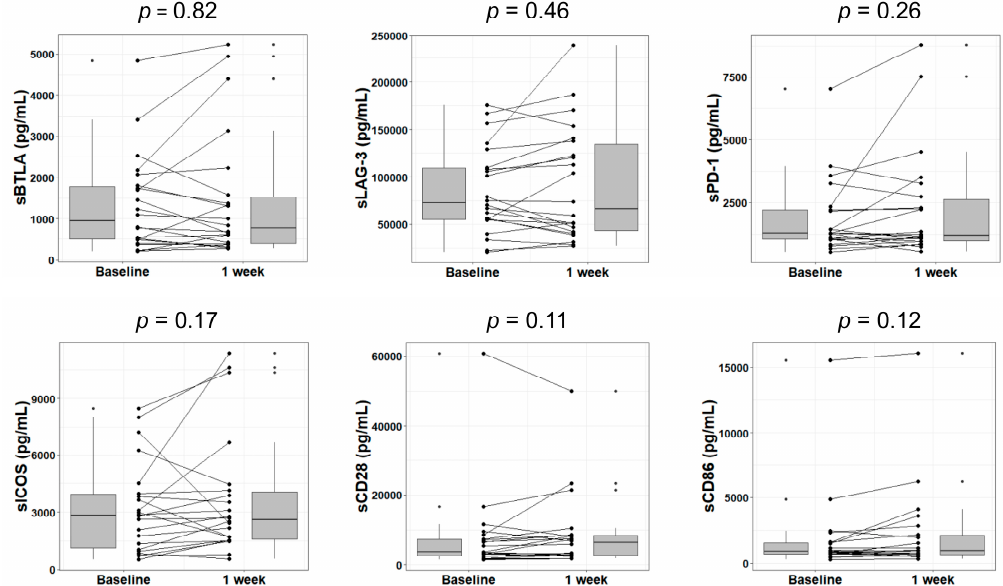
Figure A3. Changes in soluble immune checkpoint protein levels after 1 week of TACE treatment. Box plots display the sBTLA, sLAG-3, sPD-1, sICOS, sCD28, and sCD86 levels in HCC patients at baseline and Week 1 of treatment. The vertical lengths of the boxes reveal the interquartile ranges and the lines in the boxes show the median values, while the error bars suggest the minimum and maximum values (range). The Wilcoxon signed-rank test was used.